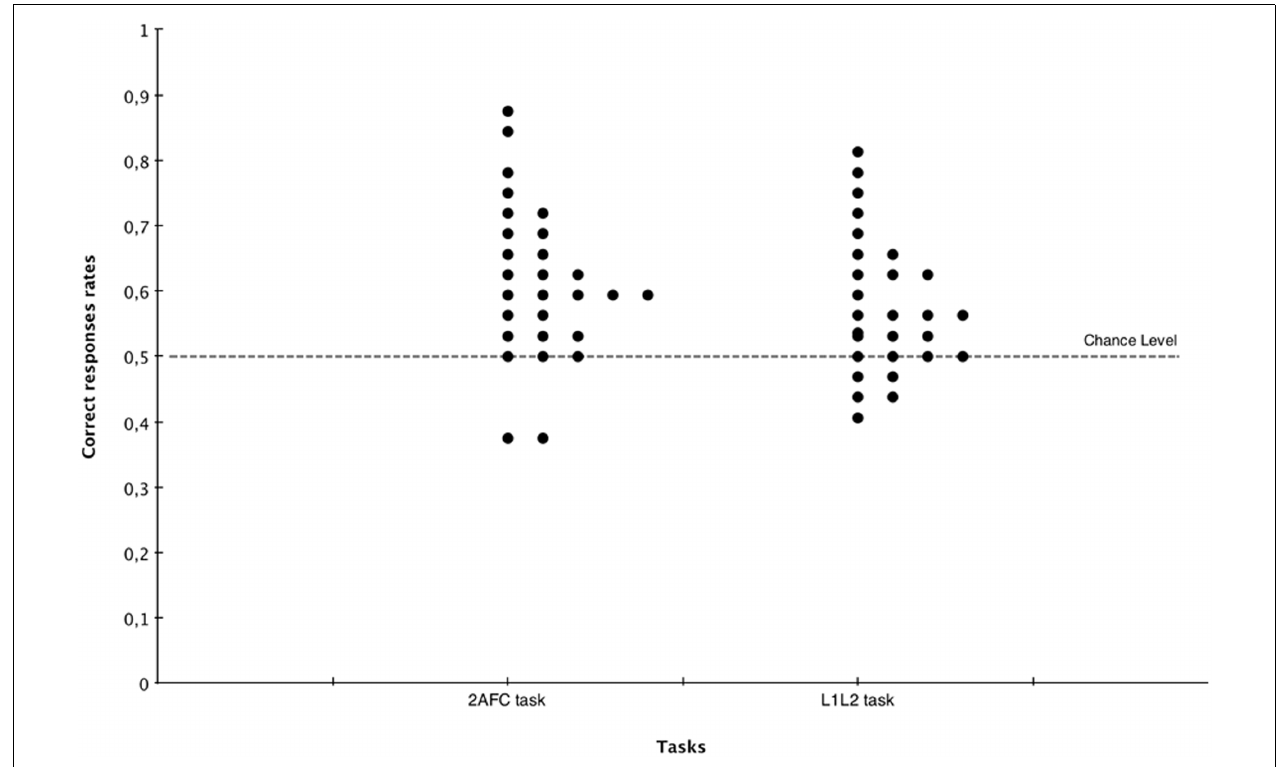
FIGURE 3 | Mean percentage of correct responses for words and non-words (plotted together) in the 2AFC task and the L1L2 decision task.